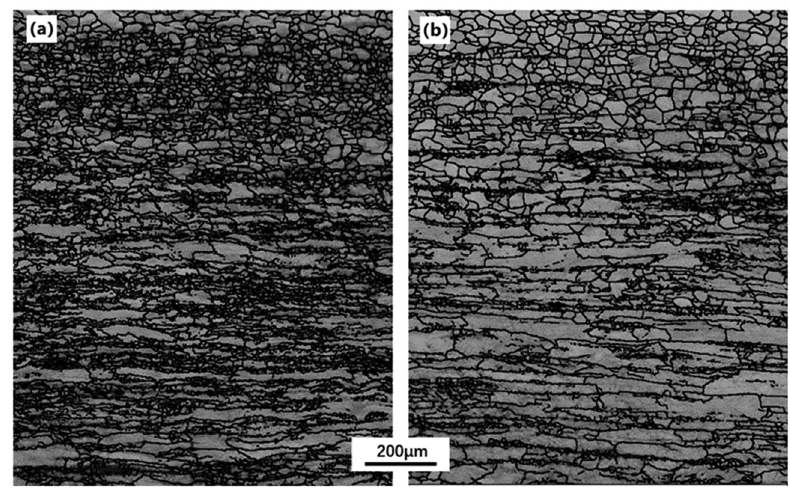
Figure 9: Microstructure of the hot - rolled sheets. ( a ) Y - free and ( b ) Y - bearing.